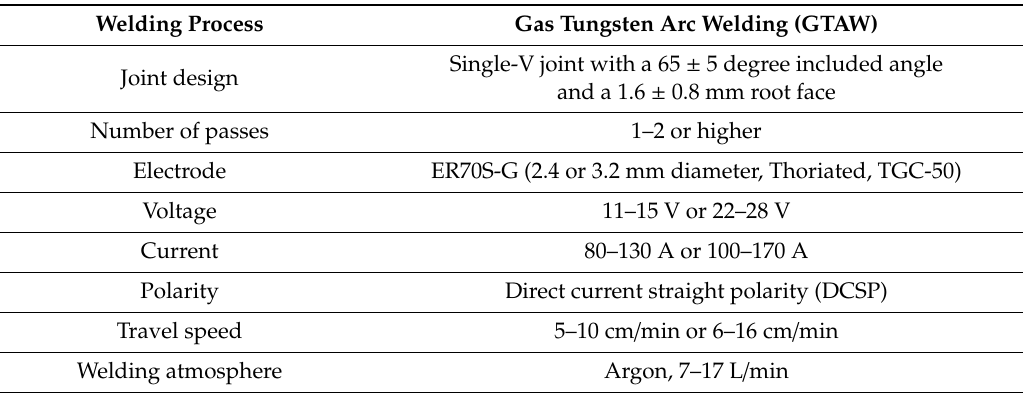
Table 2. Welding procedure